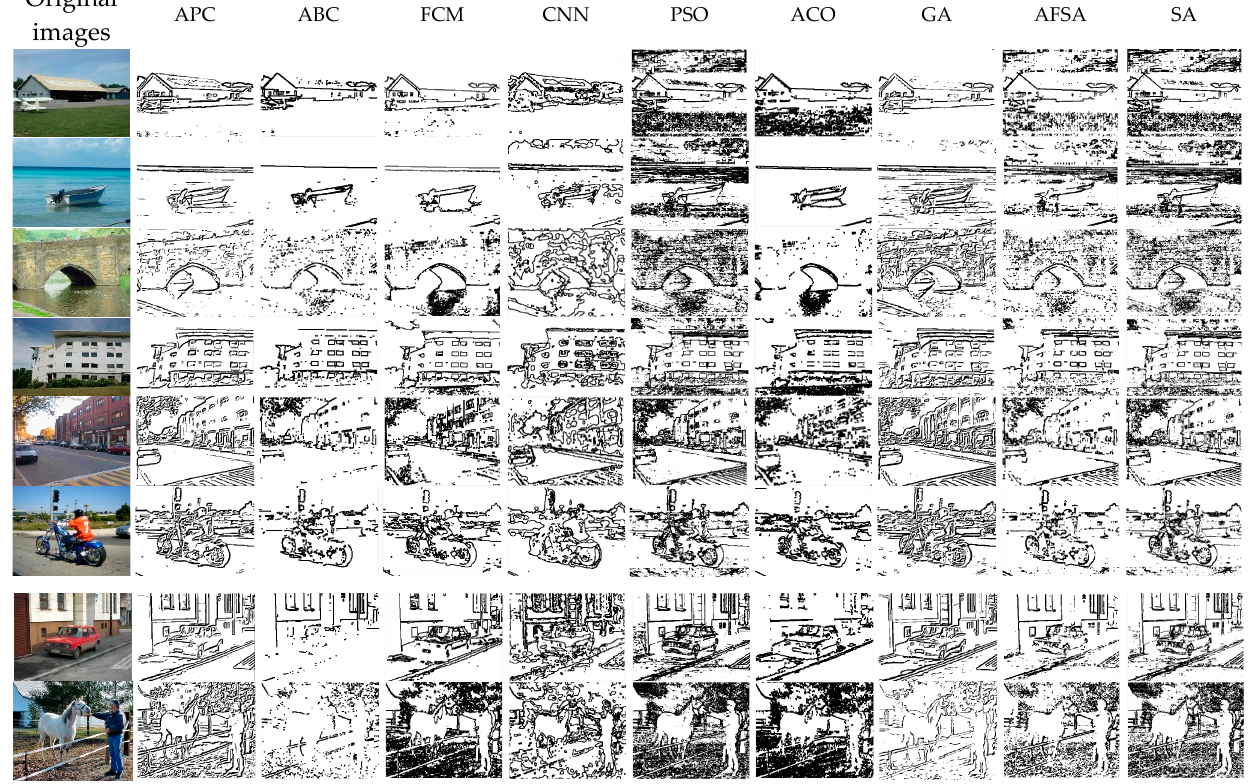
Figure 6. Algorithm comparison using the Stanford background dataset; ABC [5,41]; FCM